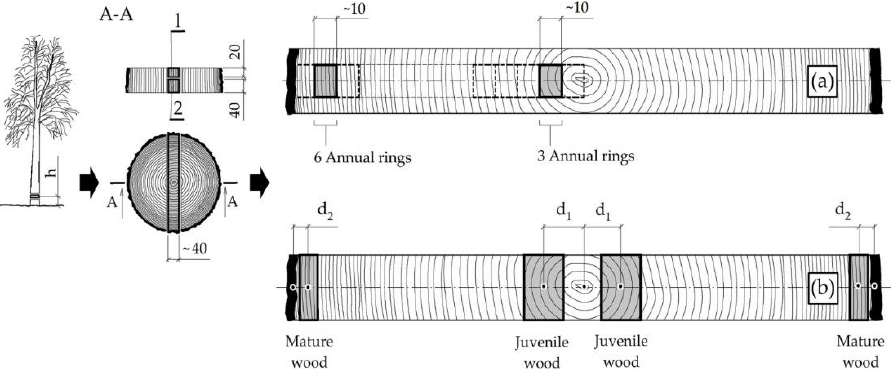
Figure 3. The scheme of a sample preparation (h—breast diameter (1.3 m), 1—main strip for ring width and basic density measurements, 2—main strip for chemical composition, content of chemical elements and sorption measurements, ( a )—cutting pattern of the samples for basic density measurements, ( b )—cutting pattern of the samples for chemical composition, content of chemical elements and sorption measurements, d 1 —distance from the pith (3 annual rings), d 2 —distance from the bark (6 annual rings), dimension in mm).